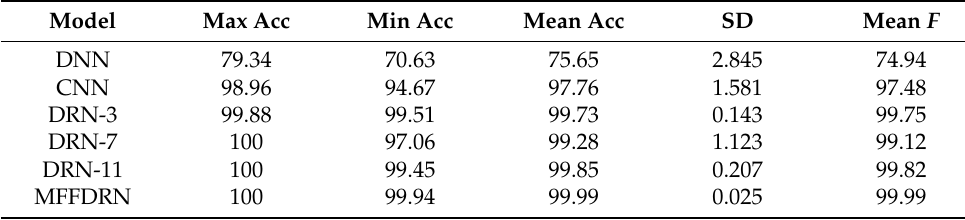
Figure 10. Diagnostic accuracy comparison of five methods in Case 2. Table 6. Experimental results in Case 2 (%).